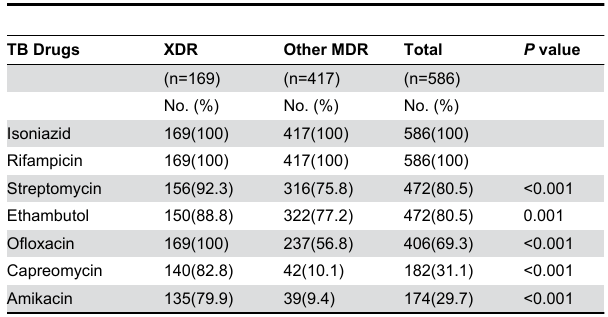
Table 3. Frequency of drug resistance among patients with XDR-TB and Other MDR-TB.